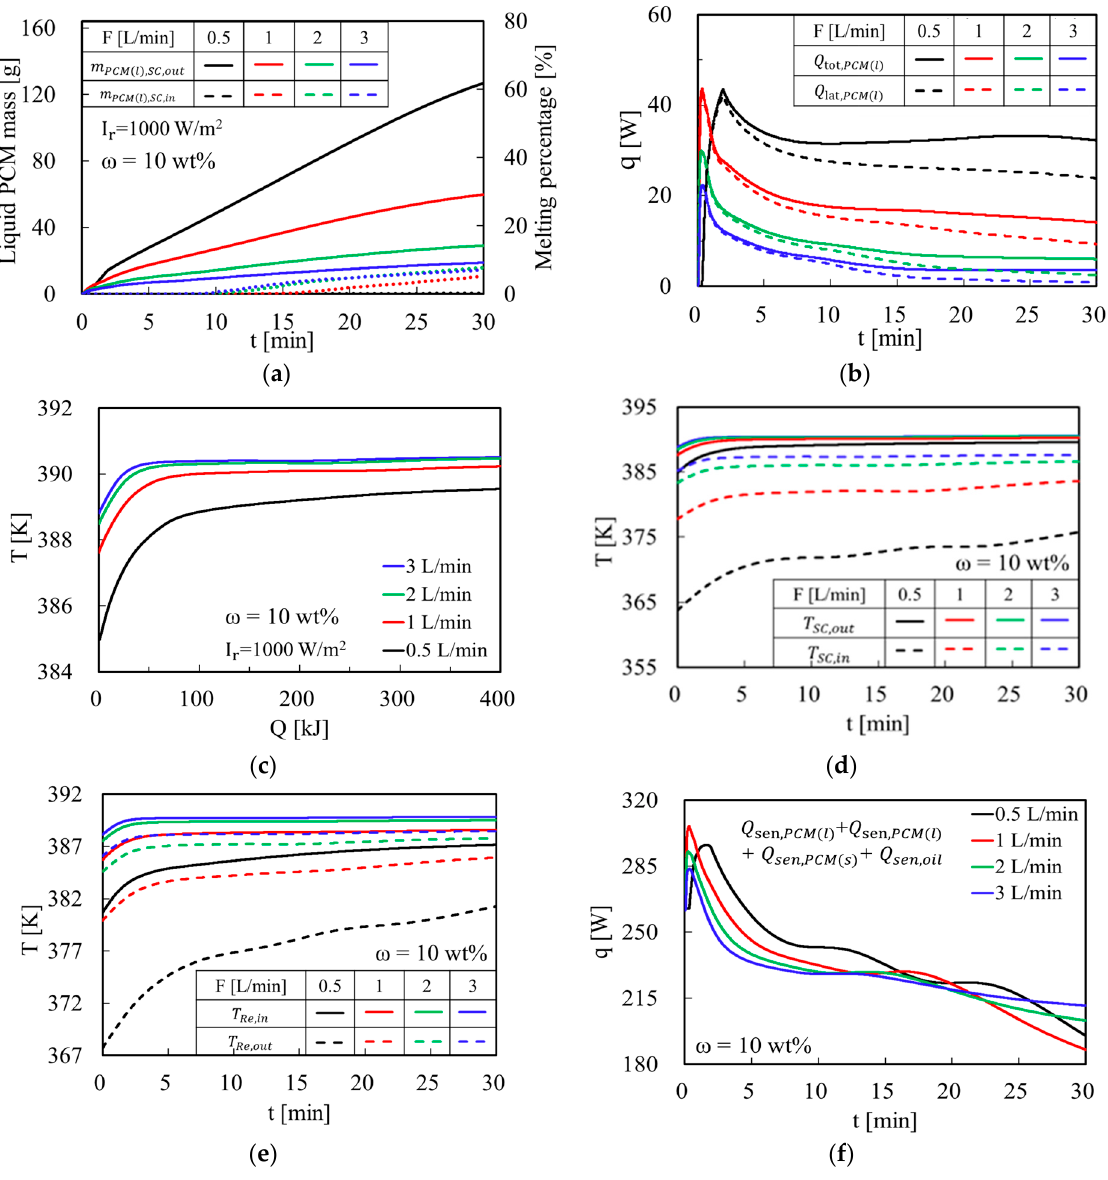
Figure 4. Several melting performances at different flow rates: ( a ) mass and melting percentage of liquid PCM over time at the SC outlet/inlet; ( b ) recovered heat forms liquid PCM; ( c ) total recovered heat (kJ) over temperature at the SC outlet; ( d ) temperature of PCM fluid at the SC inlet/outlet after melting over time; ( e ) temperature of PCM fluid at the Re inlet/outlet after melting over time; ( f ) Effects of flow rate on total recovered heat of PCM fluid, including sensible heat of silicone oil, solid PCM, liquid PCM, and latent heat of melting.